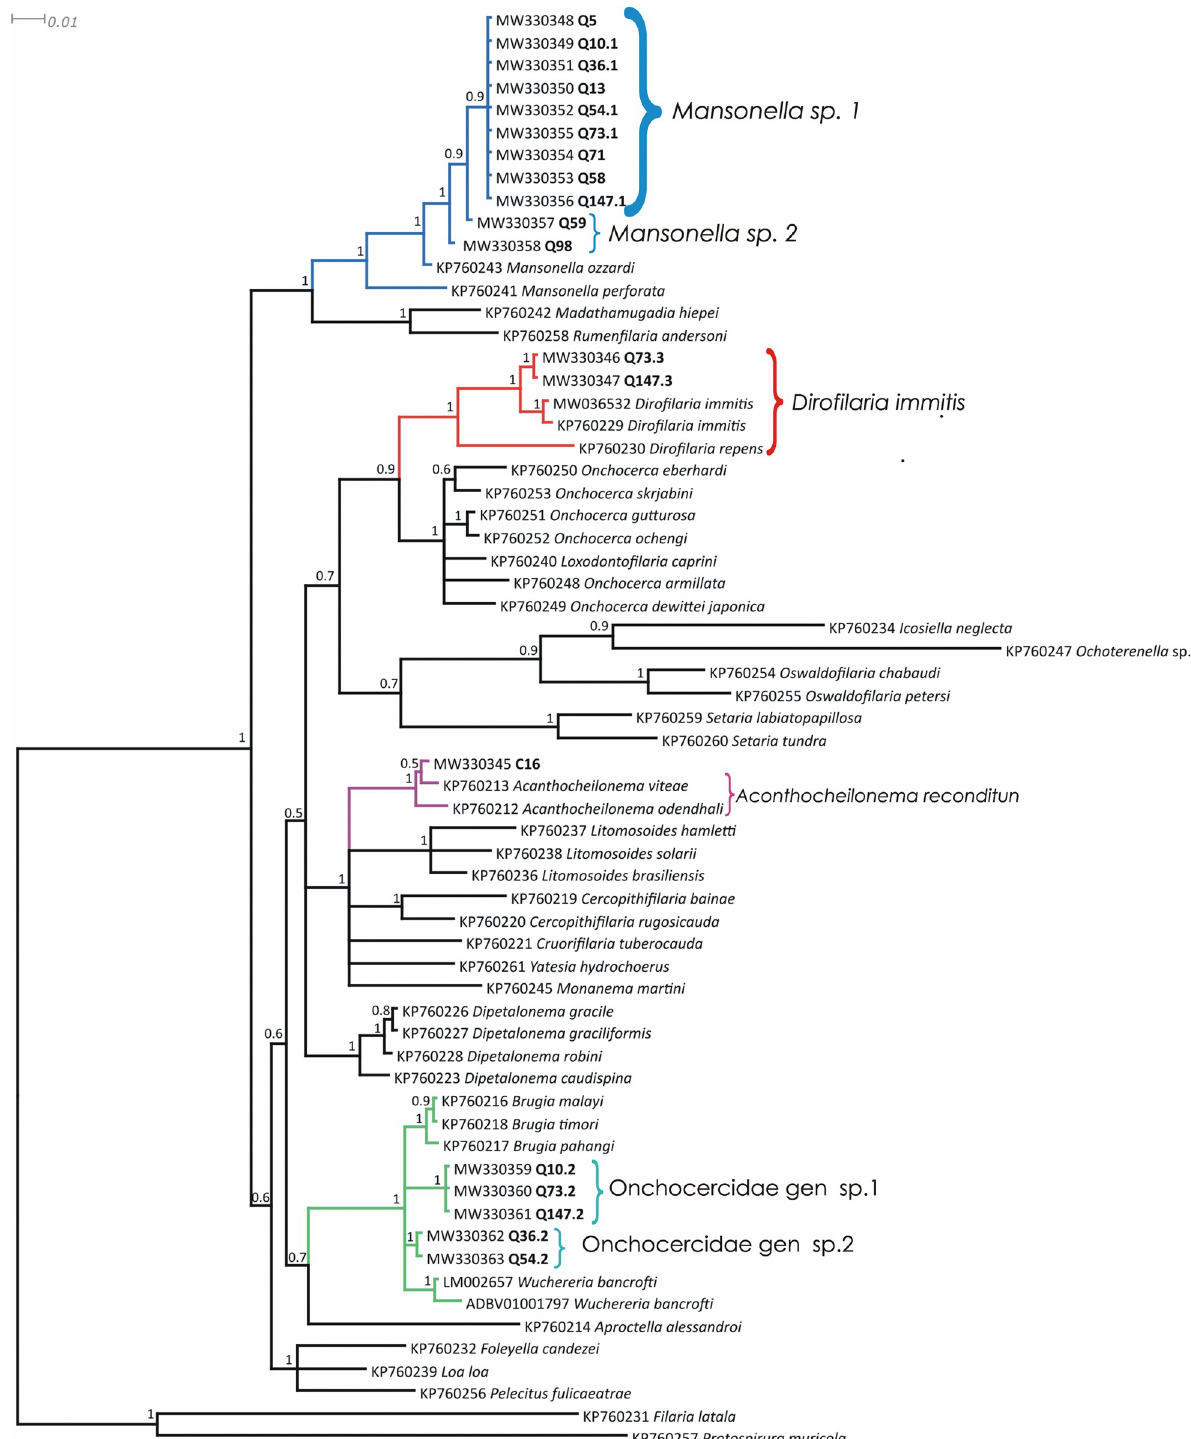
Fig 4. Bayesian phylogenetic tree of hsp70 gene sequences of Onchocercidae microfilariae haplotypes present in blood samples of ring-tailed coatis ( Nasua nasua ) and domestic dog from the Iguac¸u National Park. Isolates from this study are highlighted. The blue branches are related to Mansonella spp clade, the red branches represent Dirofilaria immitis clade, the magenta branches represent Acanthocheilonema reconditum , and the the green branches are related to the sheated species clade.